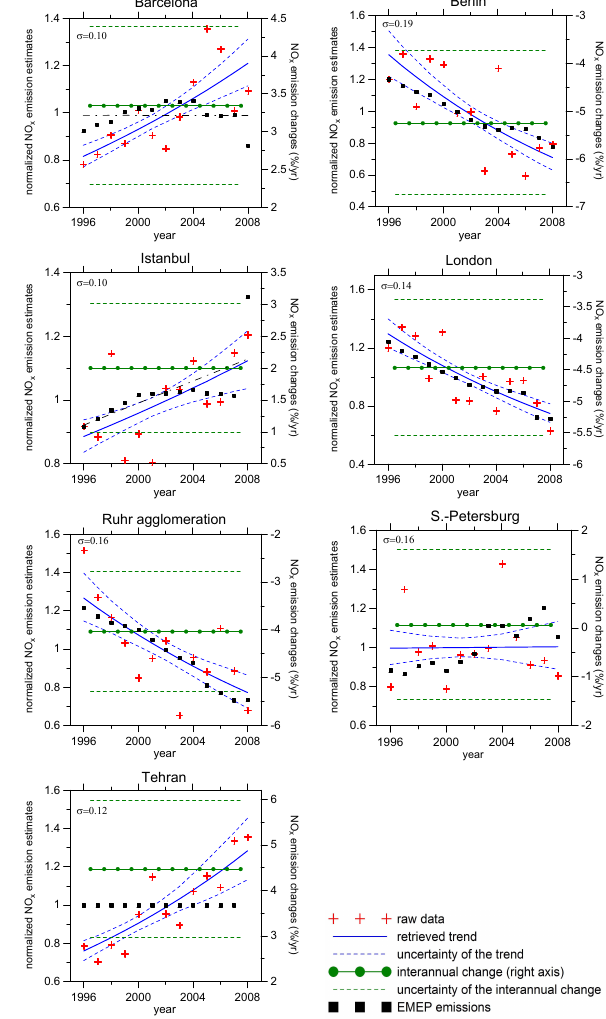
Fig. 8. The same as in Fig. 7 but for the megacity regions where sta- Fig.8. ThesameasinFig.7butforthemegacityregionswheresta- tistically significant nonlinearities in inter-annual emission changes tisticallysignificantnonlinearitiesininter-annualemissionchanges are not arenotdetected.